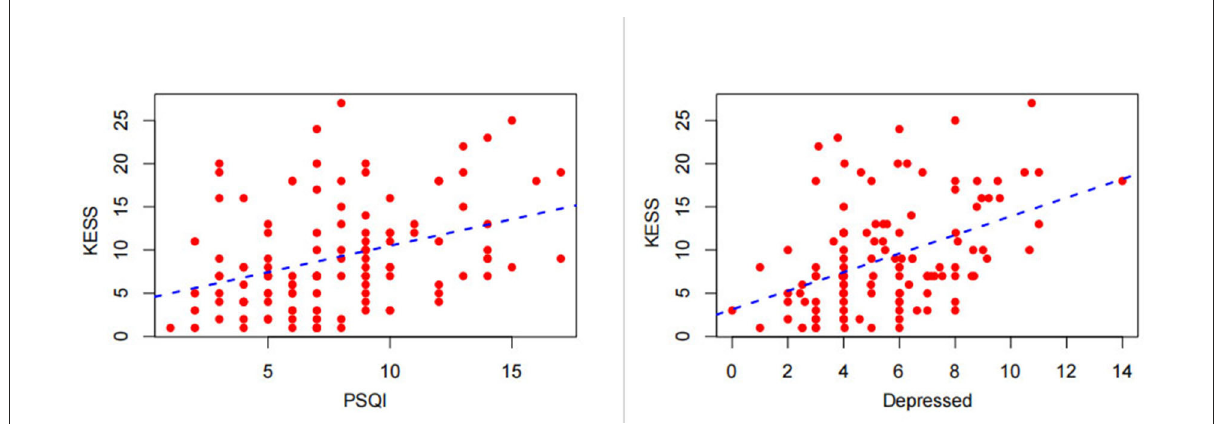
FIGURE6 Correlation of the total Knowles–Eccersley–Scott Symptom Questionnaire (KESS) score with the total Pittsburgh Sleep Quality Index (PSQI) score and Hospital Anxiety and Depression Scale (HADS)-depression score.